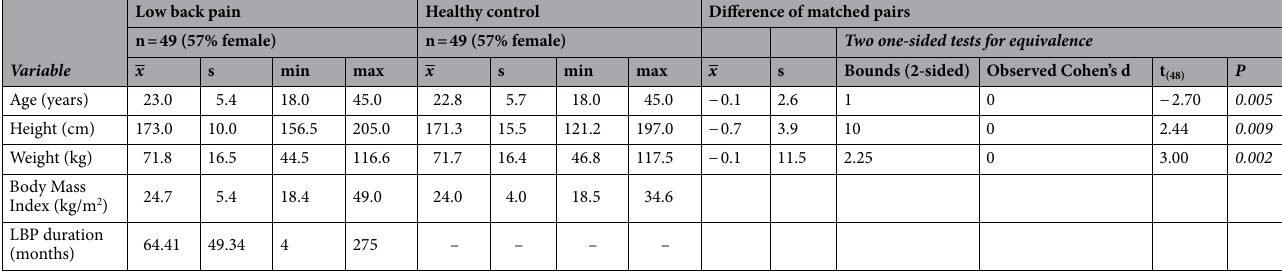
Table 1. Baseline participant